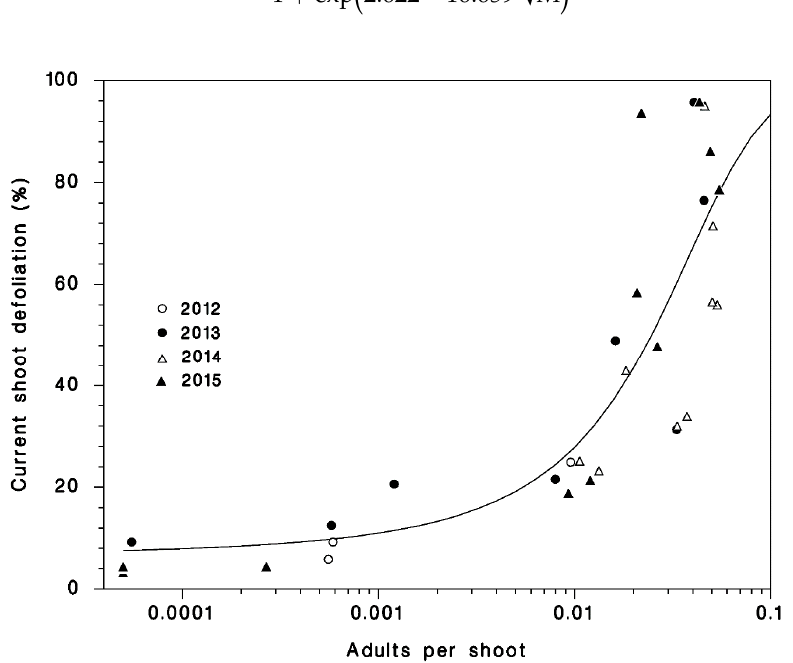
Figure 2. Relationship between adult density and defoliation of current year shoots on balsam fir foliage collected in the Lower St-Lawrence between 2012 and 2015. The line is Equation (7) .